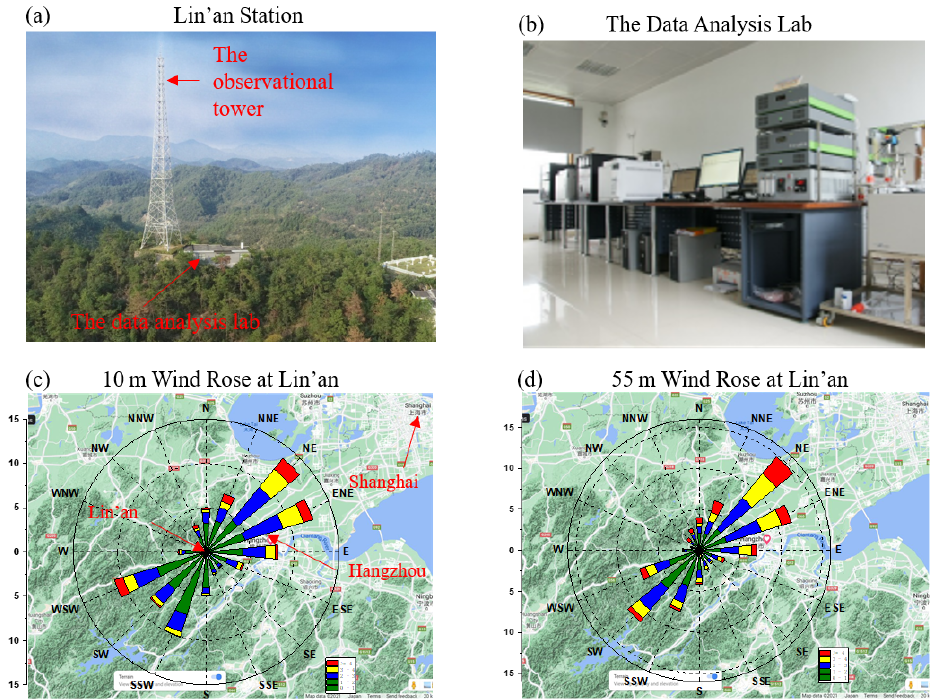
Figure 2. Photos of the (a) Lin’an regional atmospheric background station and (b) the data analysis lab. Wind rose map at Lin’an derived from wind speed and wind direction observations for 2016–2018 at (c) 10m and (d)